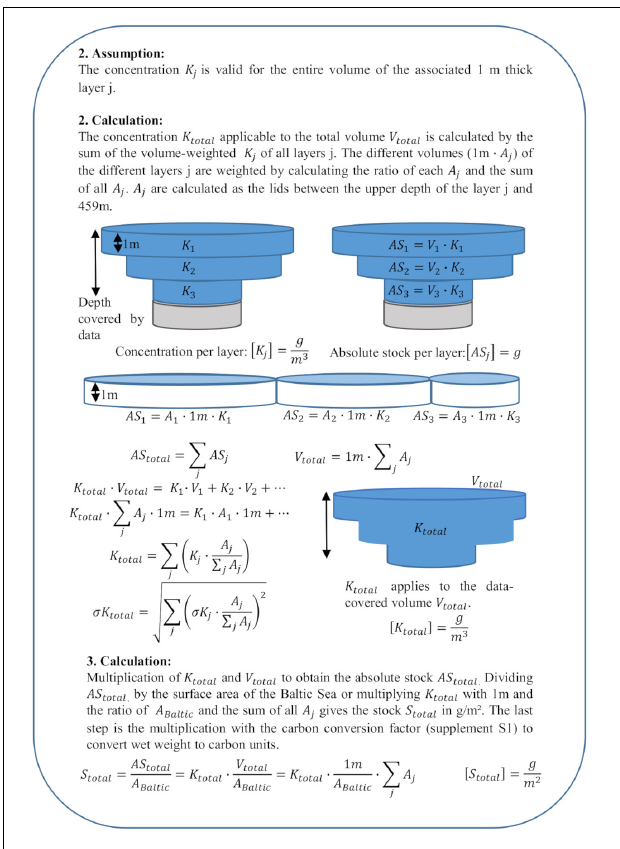
FIGURE 2 | Calculations and assumptions for case 1 stocks. AS j , absolute stock of layer j; AS total , total absolute stock of the entire volume V total ; S total , total stock in g/m 2 ; V total , total volume; V j , volume of the layer j; A j , area of the layer j; K j , mean concentration of layer j in g/m 3 ; σ K j , standard deviation of the mean concentration per layer j; K total , weighted concentration of all layers covered by the data; σ K total , standard deviation of the mean concentration; and A Baltic , area of the Baltic Sea.